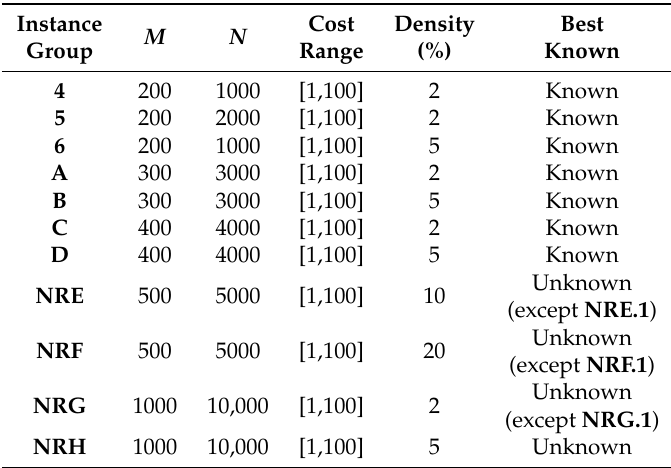
Table 1. Instances taken from the Beasley’s